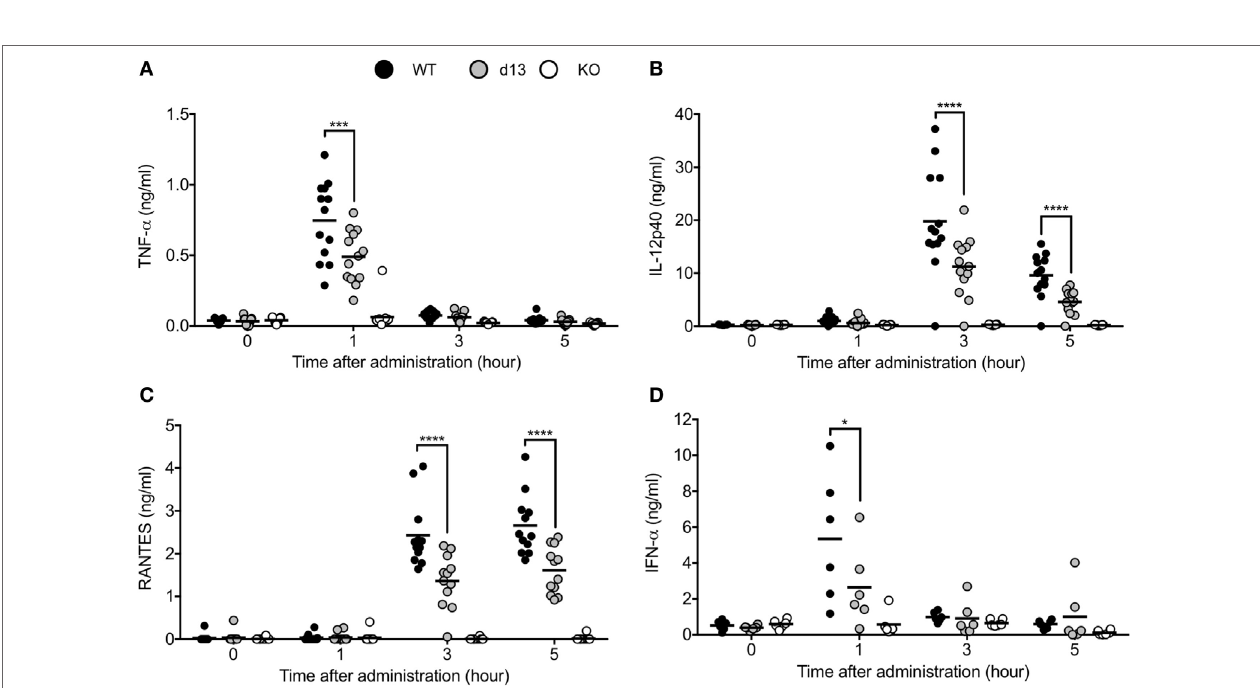
FigUre 5 | Cleavage and response of toll-like receptor 9 (TLR9) are reduced in the cells from Tlr9 d13/d13 mice. (a) The strategy to generate Tlr9 d13/d13 and Tlr9 − / − mice. (B) The genomic sequences of Tlr9 d13/d13 mice. The sequence of DNA and the transcription are shown. (c) Cleavage pattern of endogenous TLR9 in bone marrow-derived conventional DCs (BM-cDCs). TLR9 in BM-cDCs obtained from WT, Tlr9 d13/d13 , or Tlr9 − / − mice was detected by immunoprecipitation and immunoblotting. β -actin in whole cell lysate (WCL) was detected as an internal control. The intensity of the bands was quantified and shown in the table. (D) BM-cDCs obtained from WT, Tlr9 d13/d13 , or Tlr9 − / − mice were stimulated by TLR9 or TLR4 ligand. After 24 h incubation, IL-6 in culture medium was detected by ELISA. Cells were stimulated in triplicated wells and the mean SD is shown. At least three times of experiments were performed independently (c,D) . Data were statistically analyzed by two-way ANOVA with multiple comparisons (D) . **** p < 0.0001. Abbreviations: ND, not detected; N/A, not